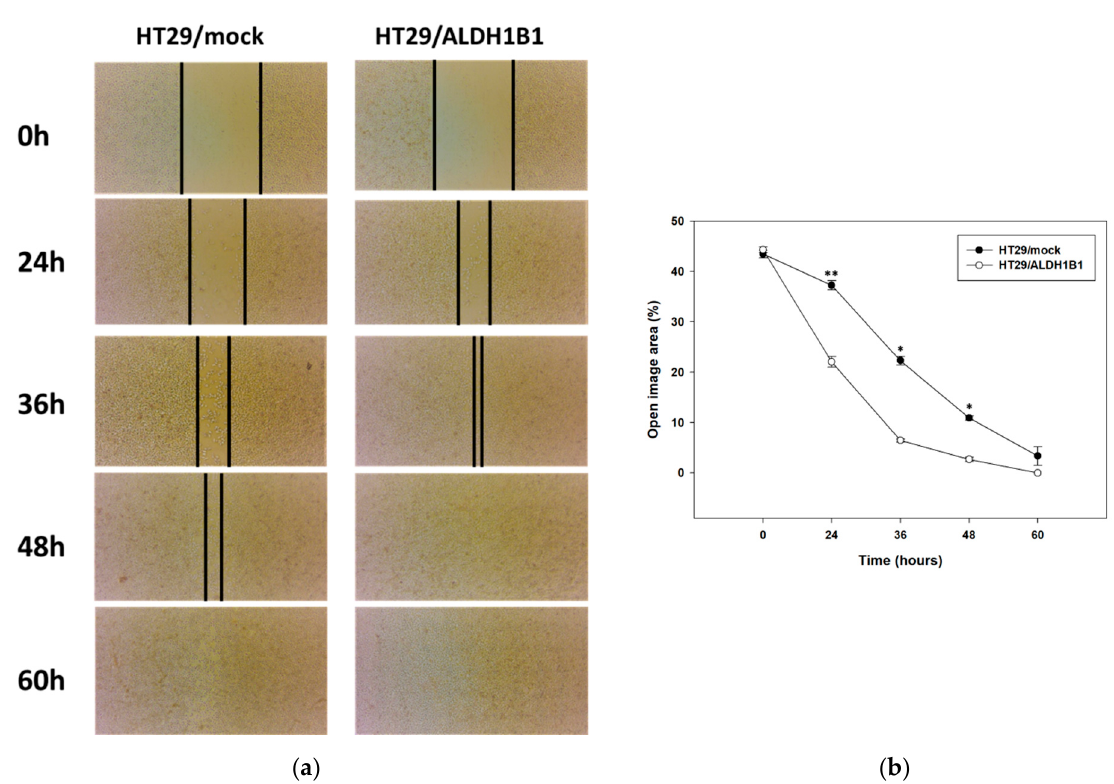
Figure 7. ALDH1B1 is related to the increased migratory potential in HT29 cells. ( a ) Scratch assay for the HT29 isogenic cell line pair. At the indicated time points, cell migration was monitored under an optical microscope (magnification 20 × ). ( b ) Quantification of the percentage of wound closure by ImageJ software analysis in HT29 cells. Data are presented as mean ± SD of three independent experiments. * p < 0.05 and ** p < 0.01.